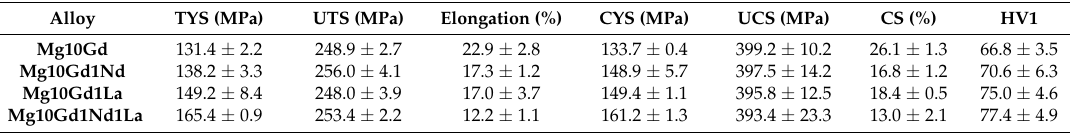
Table 1. Tensile and compressive properties and hardness properties of extruded alloys [5].